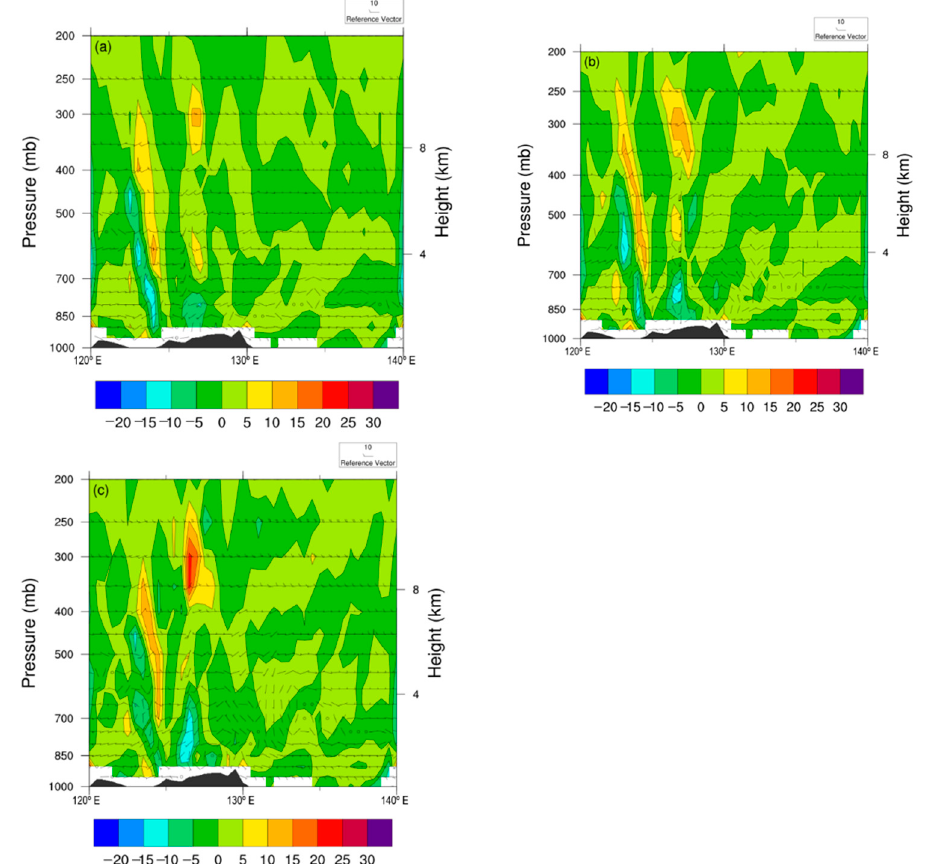
Figure 13. Vertical profile of the resultant wind (Plume) along latitudinal 42.5° N divergence (shaded, unit: 10 − 5 s − 1 ), u and w * 20 (barbs; m/s) at ( a ) 19:00 ( b ) 20:00 ( c ) 21:00 UTC on 14 August 2019.